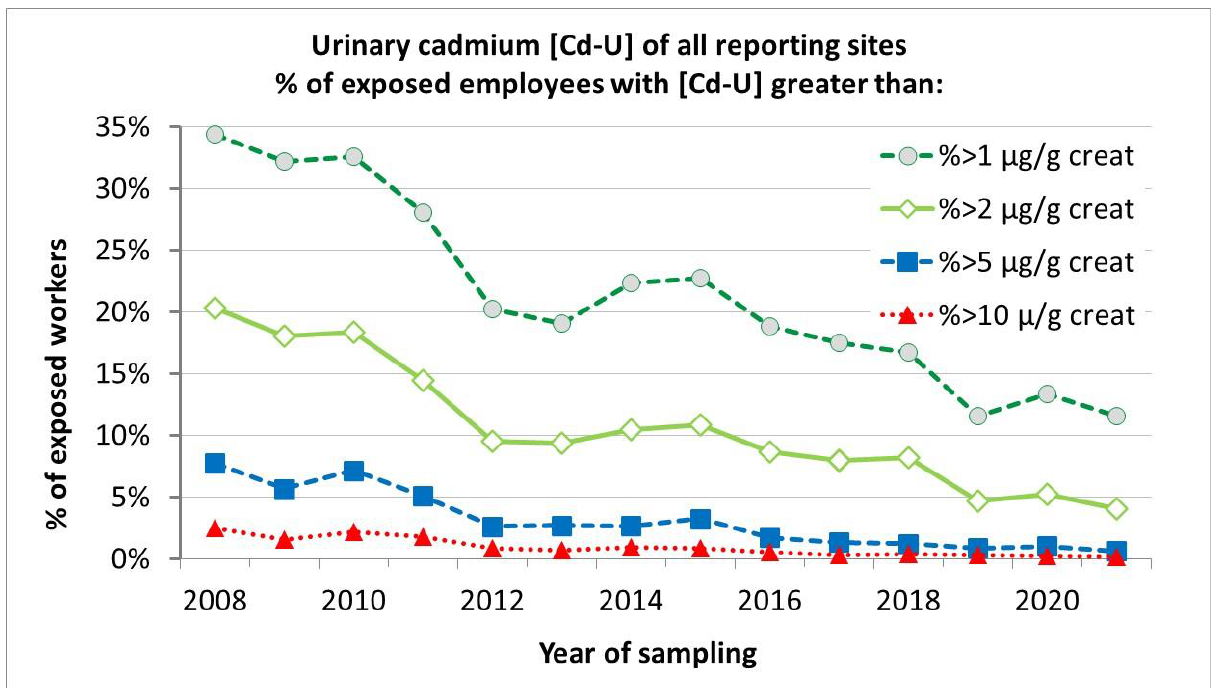
Figure 3. Reported urinary cadmium levels as % of exposed employees with Cd-U greater than x µg Cd/g creatinine from the period 2008–2021. Cd/g creatinine from the period